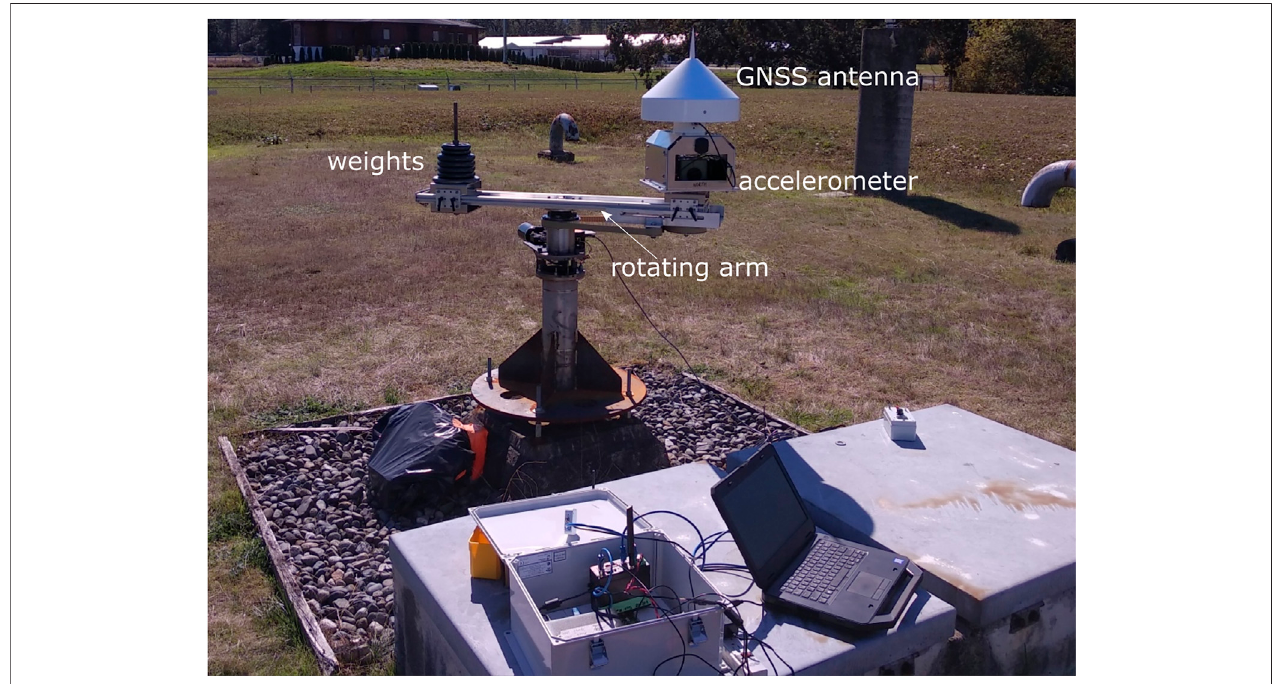
FIGURE 3 | The rotating system of an accelerometer and GNSS antenna used for testing the EEW detection algorithms. The base holding the antenna and accelerometer does not change relative orientation while testing. The plan and design was developed by Natural Resources Canada (NRCan) (1975) and the Geodetic Survey of Canada (GSC).